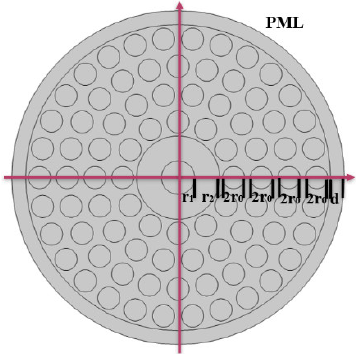
Figure 1. Schematic diagram of the terahertz OAM PCF.